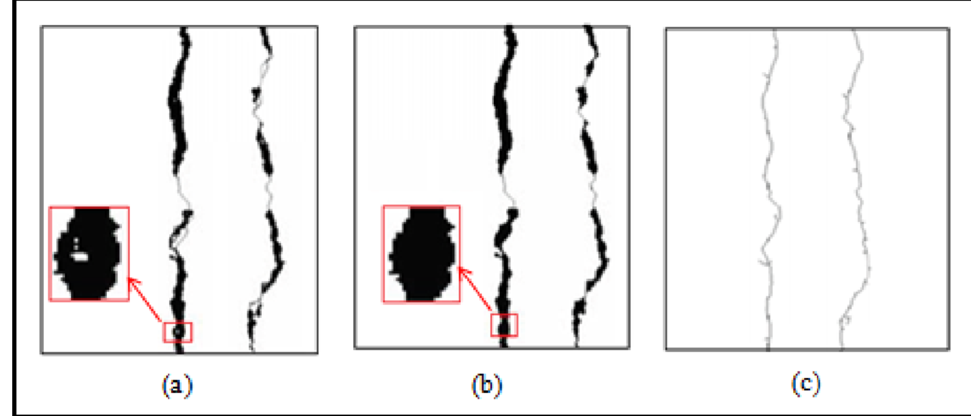
Figure 3. Principle of morphological filtering. ( a ) Binarized Image, ( b ) Small hole filling results, ( c ) Skeletonization